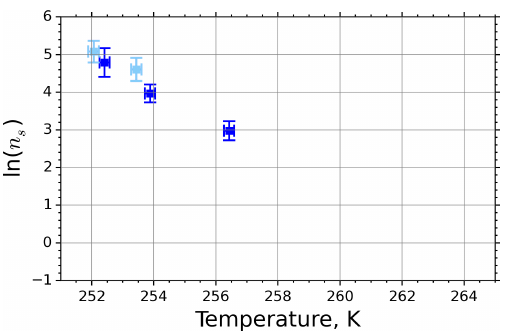
Figure 3. Measured surface temperatures of two droplets levitated in the M-AL: examples of freezing (red line) and non-freezing (black line) events. The measurement uncertainty in the tempera- ture was ± 0 . 5K.